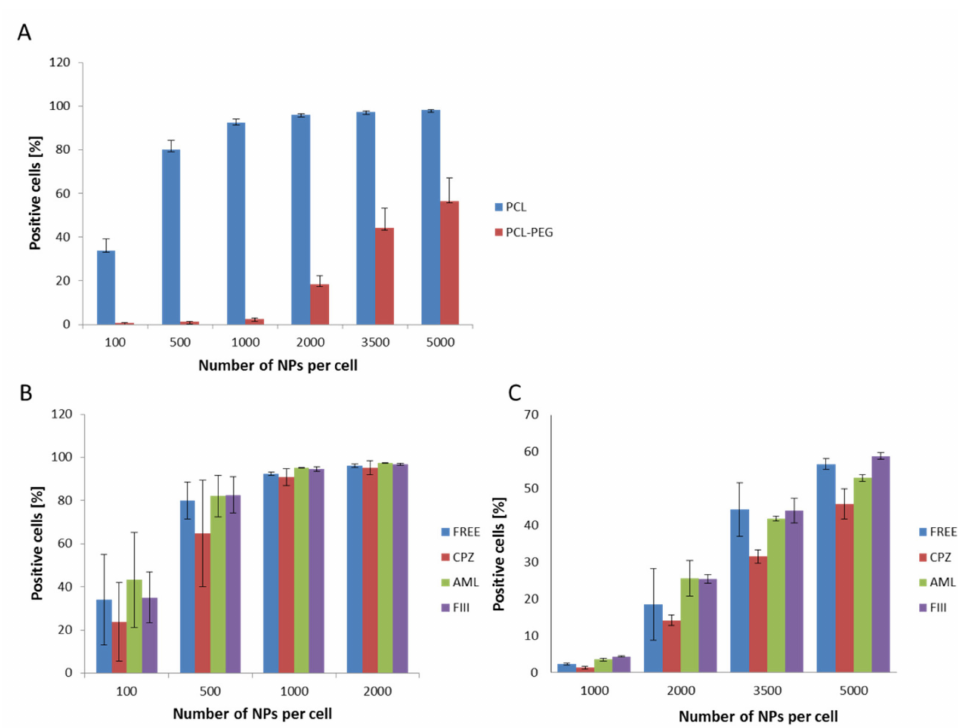
Figure 5. Internalization assessment of various types of PCL NPs by the RAW 254.7 cells (flow cytometry measurements). ( A ) Measurements for different NP doses ( B , C ), showing the influence of specific endocytosis inhibitors (CPZ-chlorpromazine, AML-amiloride, FIII-filipino III) on NPs internalization. The results obtained for CPZ were significantly different (Student’s t test) from the control (non-treated cells). ( B ) Non-pegylated PCL NPs. ( C ) Pegylated PCL NPs. Data represent the ± standard error of the mean